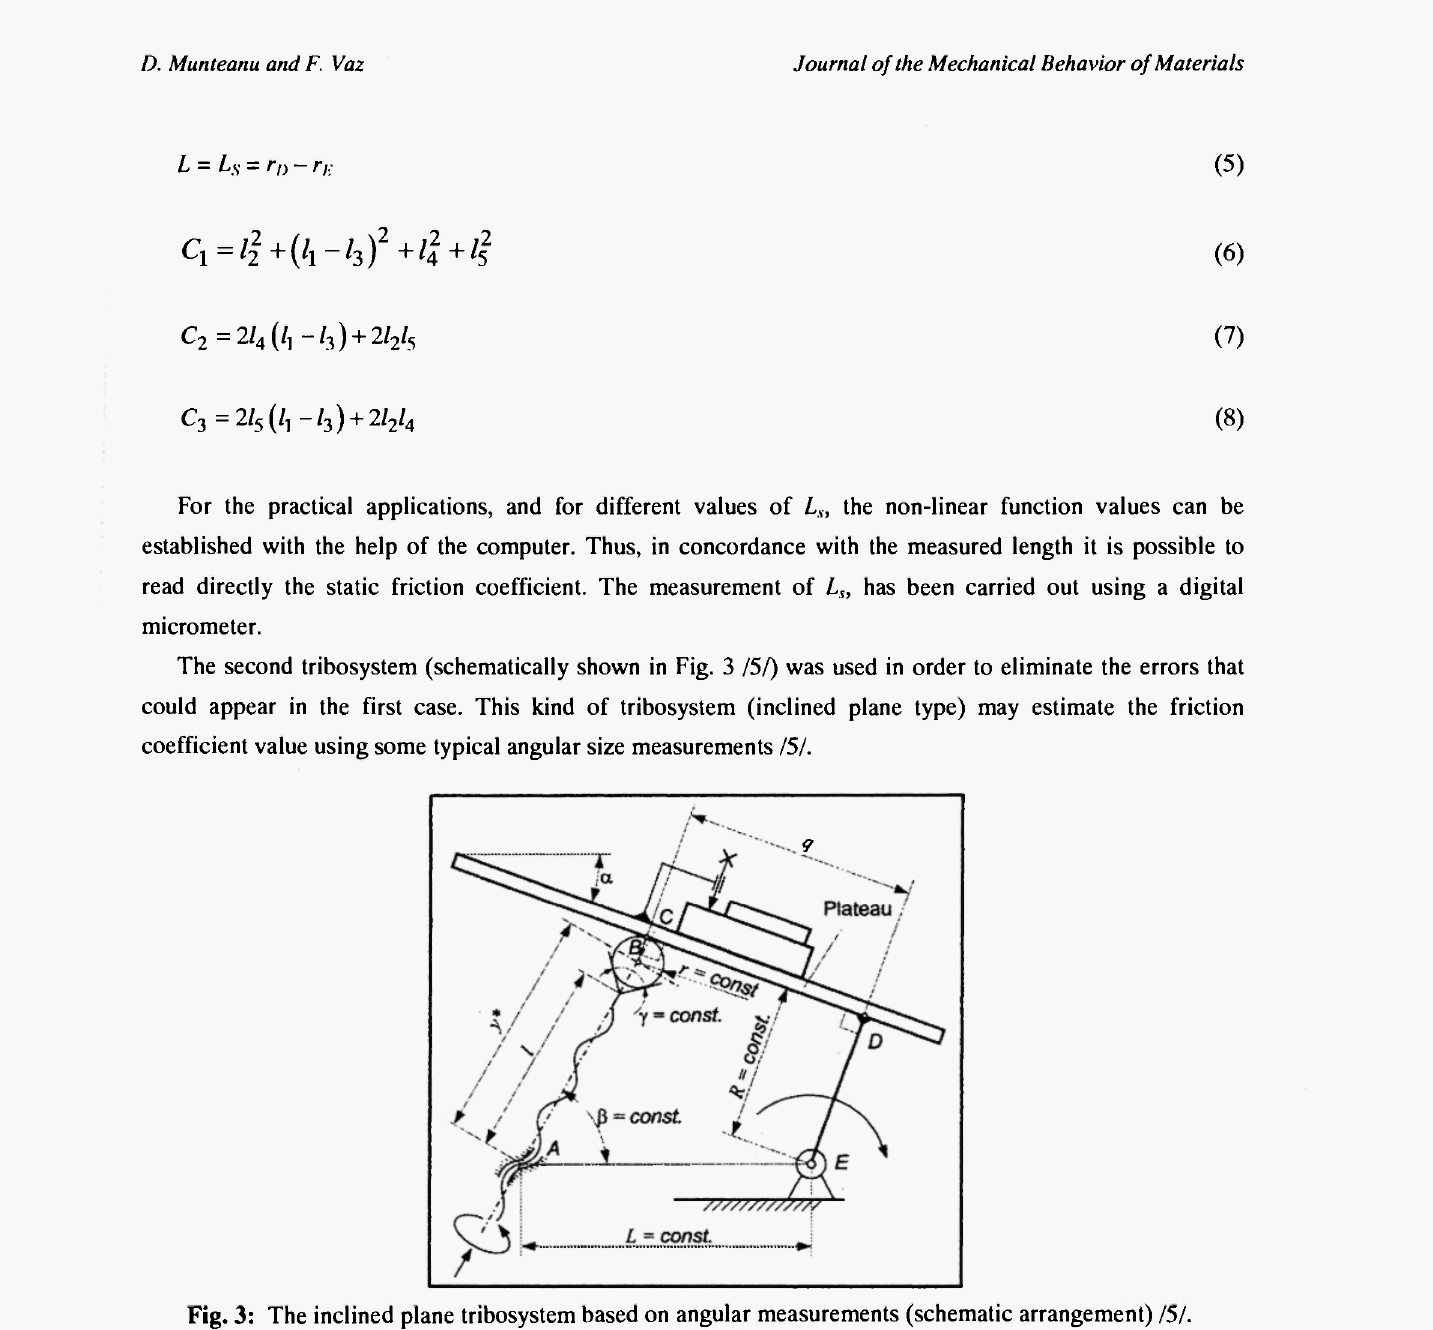
Fig. 3: The inclined plane tribosystem based on angular measurements (schematic arrangement) 151.